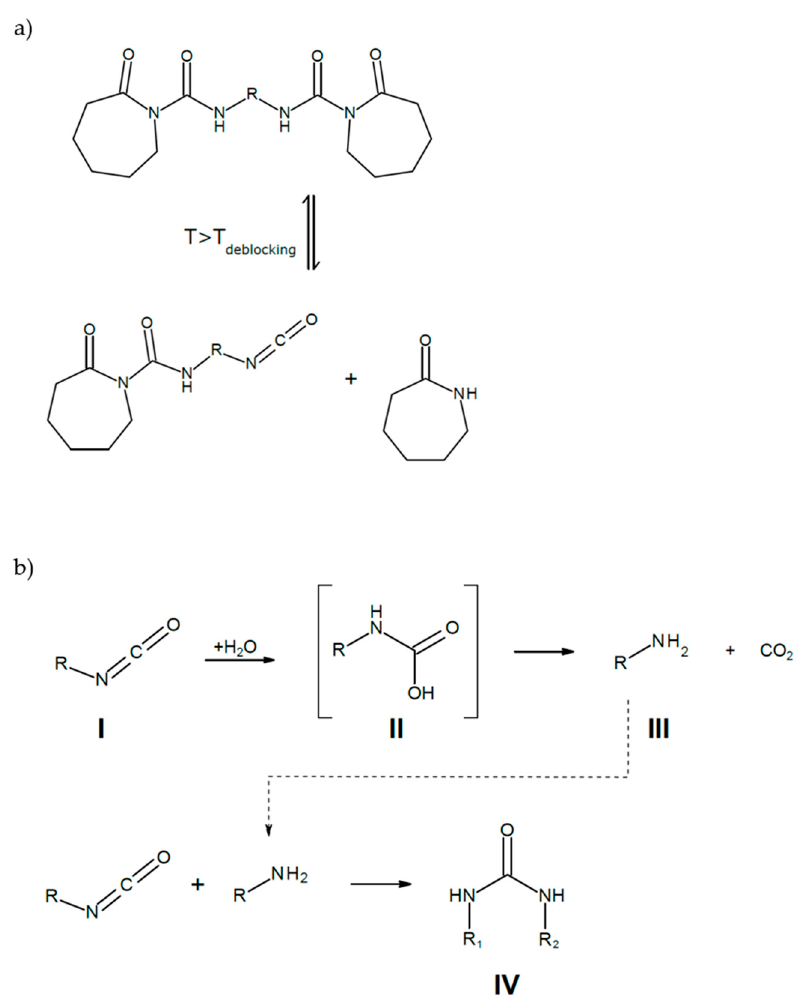
Figure 2. ( a ) Deblocking of the activator by exceeding the deblocking temperature and ( b ) possible reaction steps for the deactivation of the activator hexamethylene-1,6-diisocyanate (Brüggolen C20P) by water.